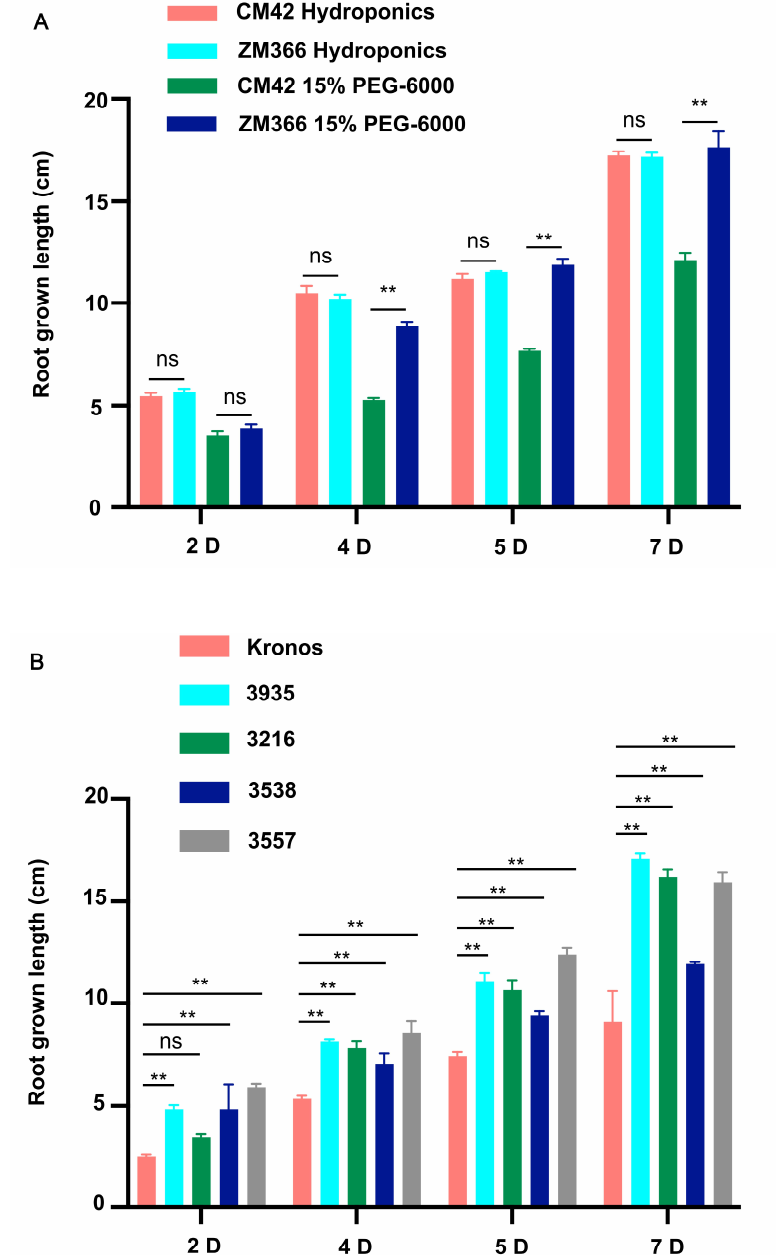
Figure 2. Root growth length statistics. ( A ) Statistics of CM42 and ZM366 under hydroponics and the 15% PEG-6000 treatment. ( B ) Statistics of Kronos and 4 EMS-induced mutants under the 15% PEG-6000 treatment. Growth was measured on days 2, 4, 5, and 7. The experiment was repeated three times, and the error bar represents the SD of the means ( n = 3). ** represents p < 0.01. ns indicates not signi fi cant.